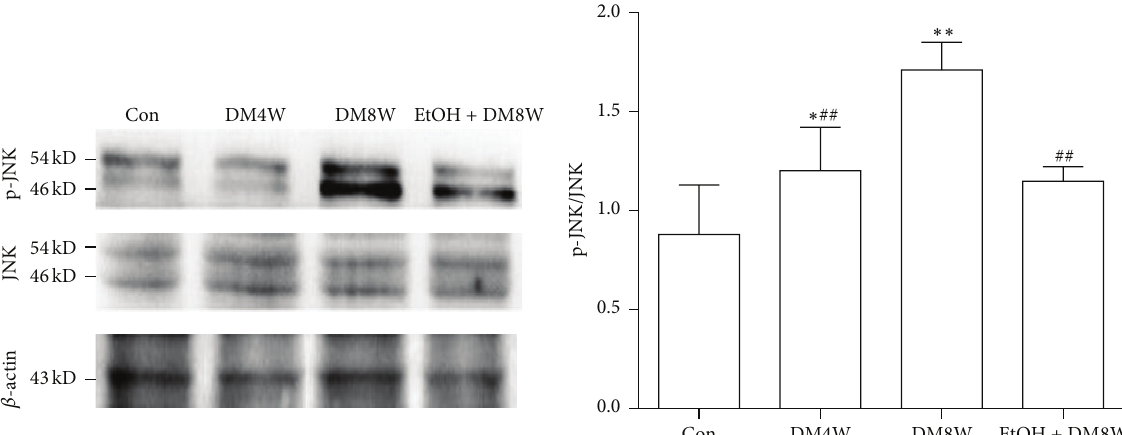
Figure 2: The result of myocardial JNK and phospho-JNK protein: ∗ 𝑃 < 0.05 and ∗∗ 𝑃 < 0.01 compared with Con; # 𝑃 < 0.05 and ## 𝑃 < 0.01 compared with